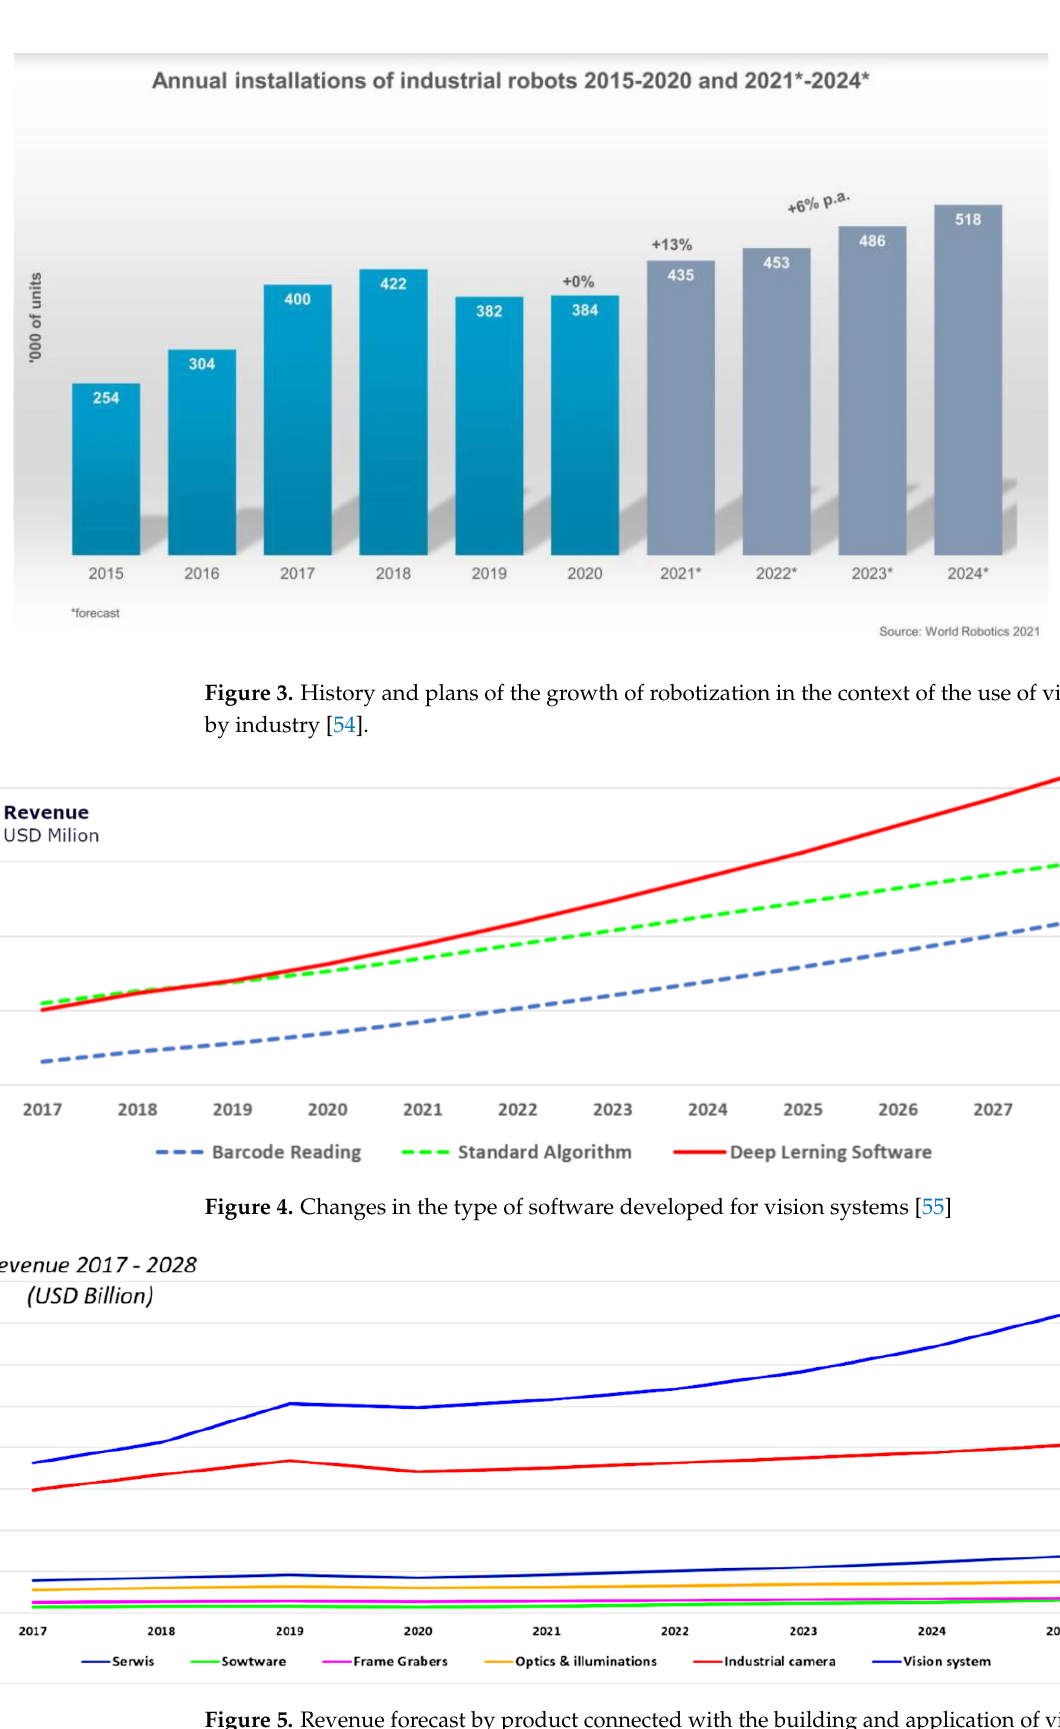
Figure 5. Revenue forecast by product connected with the building and application of vision systems in the manufacturing industry